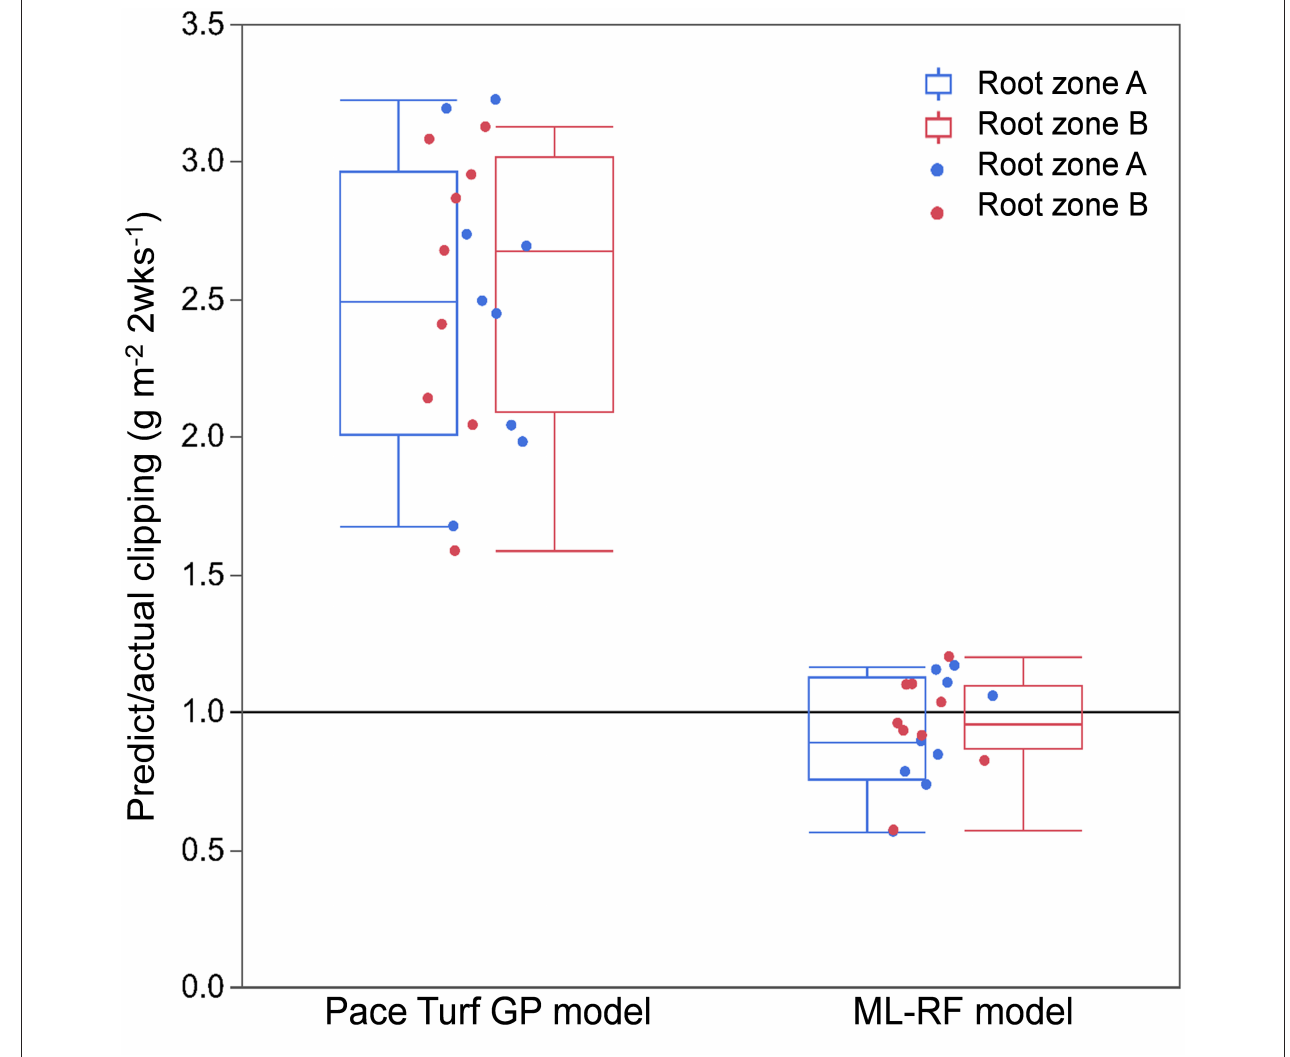
FIGURE 4 | Creeping bentgrass growth prediction accuracy of PACE Turf growth potential (GP) model and machine learning-random forest (ML-RF) model. Blue boxes and dots represent data collected on root zone A and red boxes and dots represent data collected on root zone B. The boxplots were set at maximum, 75th (the upper quartile), median, and 25th (the lower quartile), and